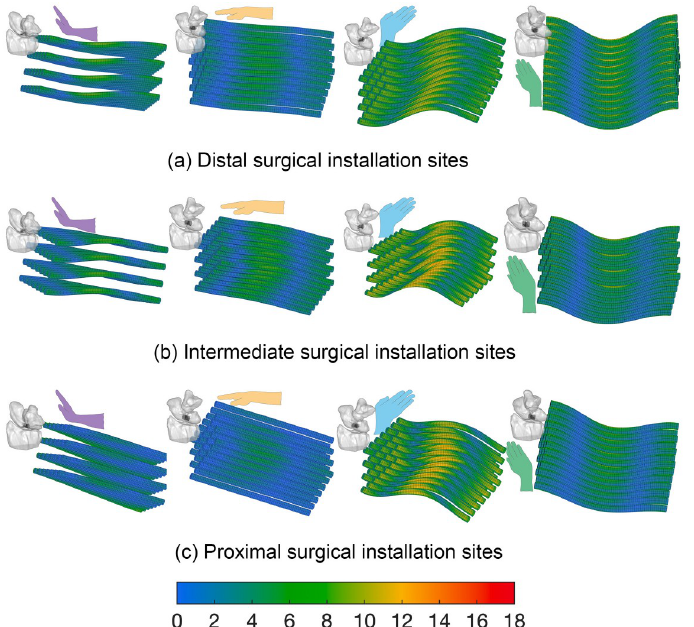
Fig 14. Von Mises stress distribution on the 7 mm ligament-scaffold at three surgical installation sites. (a) The distal (Fig 5b); (b) intermediate (Fig 5c); (c) proximal (Fig 5d) in the dorsal view of the wrist being in positions of extension, neutral, ulnar deviation, and radial deviation. The von Mises stress scale bar is from 1 to 18 MPa.